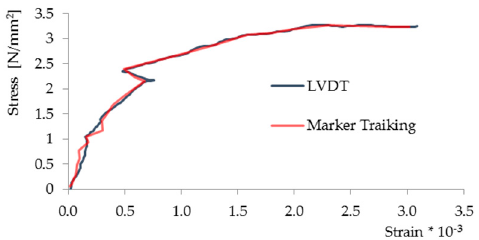
Figure 8. Displacement measurement with linear variable displacement transducers (LVDT) and the proposed methodology (MT).